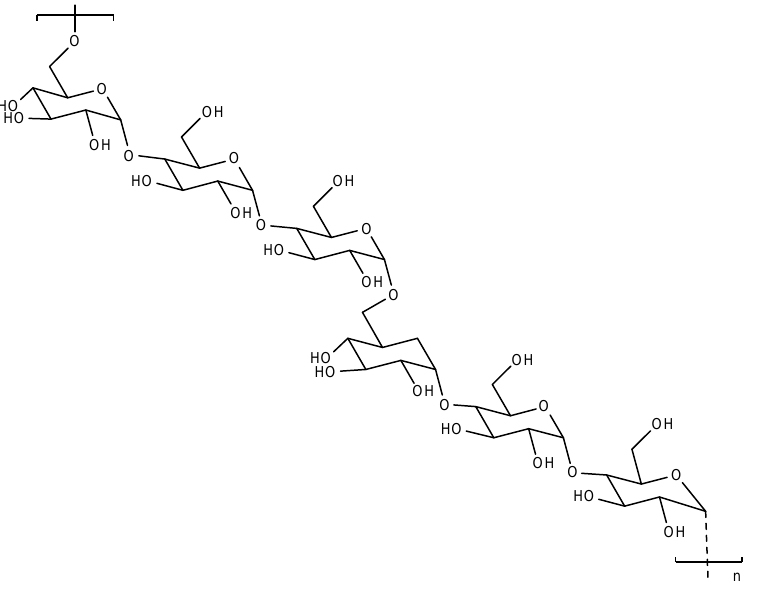
Figure 9. The structure of